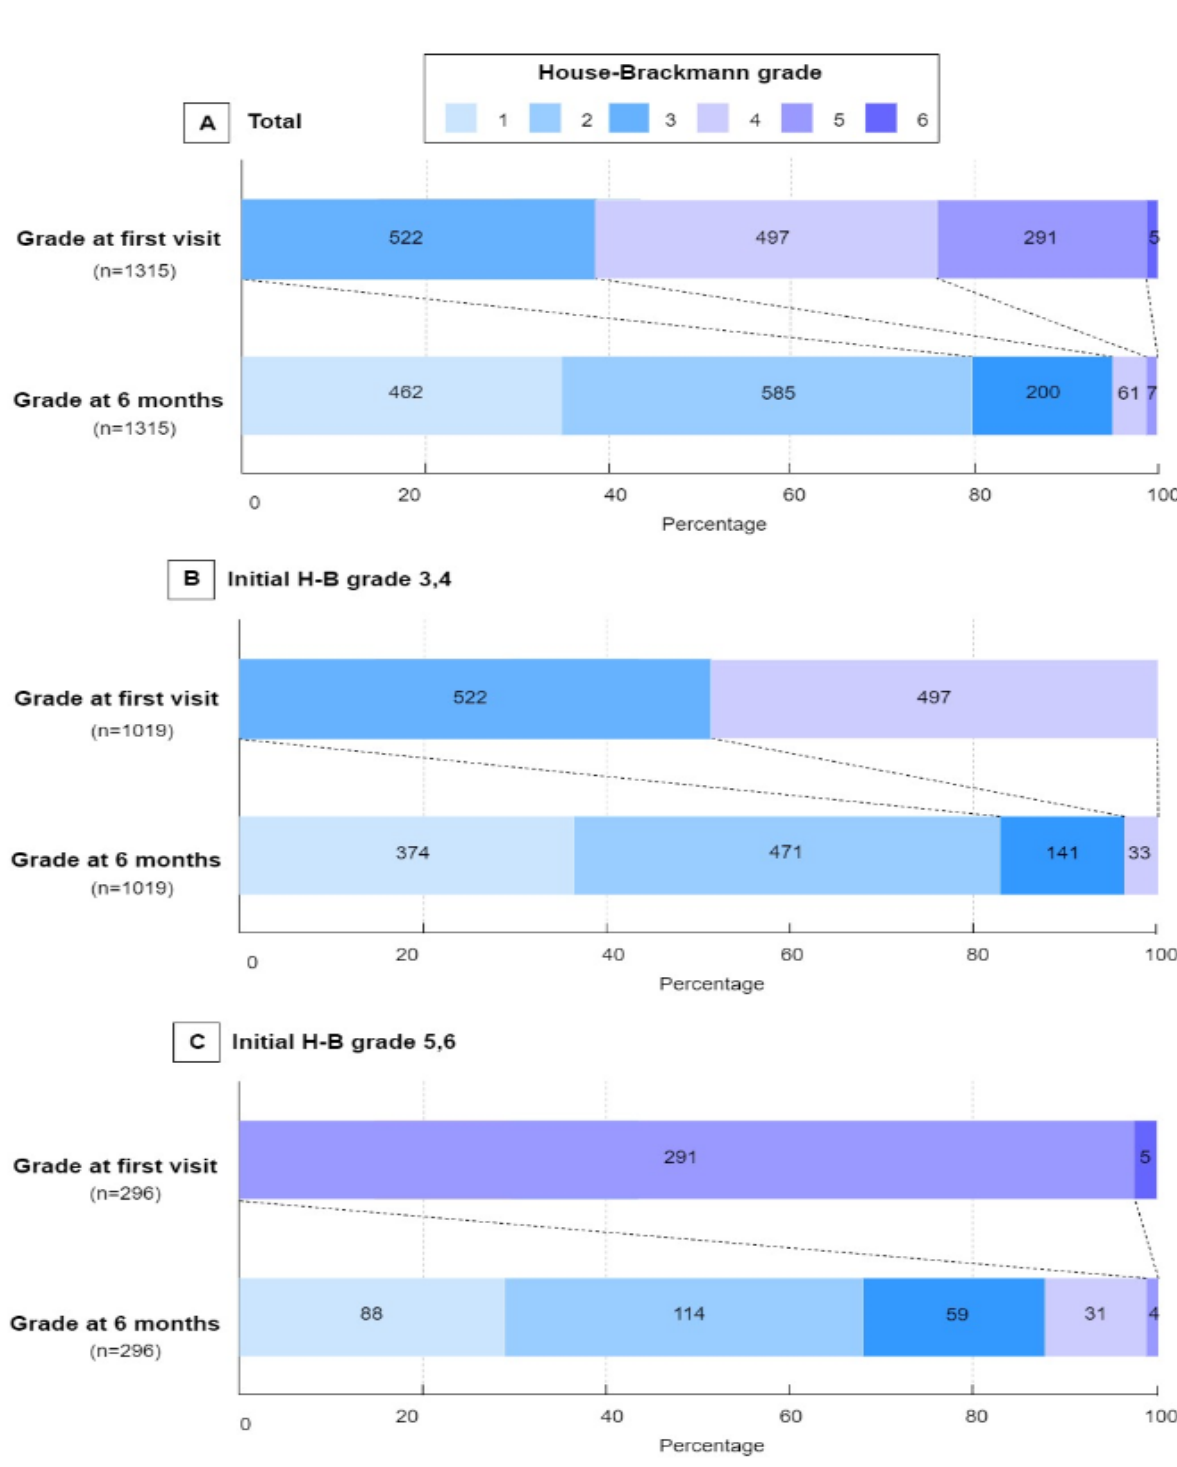
Figure 2. Distribution of the House–Brackmann grade at initially and at 6 months. The House–Brackmann (H-B) grade ranges from 1 (indicating normal) to 6 (total paralysis). Each cell corresponds with an H-B grade; the width of the cell represents the proportion of patients with equivalent grades and the number of patients is displayed within the cell.